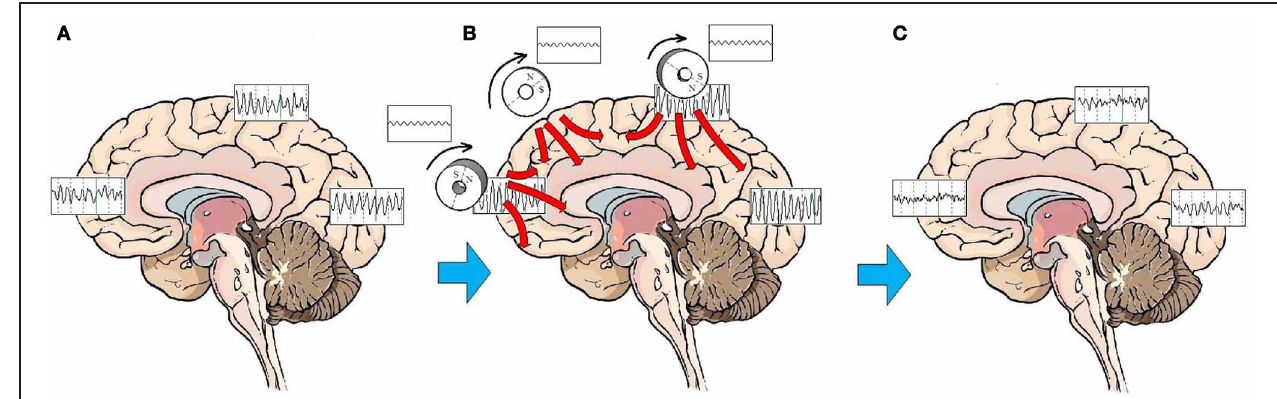
FIGURE 2 | Effects of sTMS stimulation on brain function. On average, patients with MDD exhibit a pattern of highly synchronous theta and alpha activity seen broadly over most brain regions (A) . The low-amplitude sinusoidal stimulation provided by the neodymium magnets rotating at the IAF entrains brain oscillatory activity to the frequency of stimulation for the duration of the stimulation